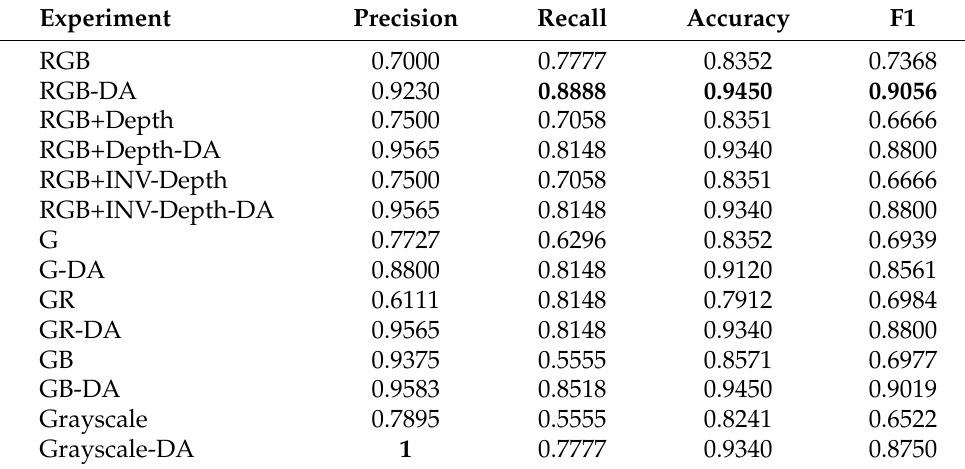
Table 2. Quantitative results (higher is